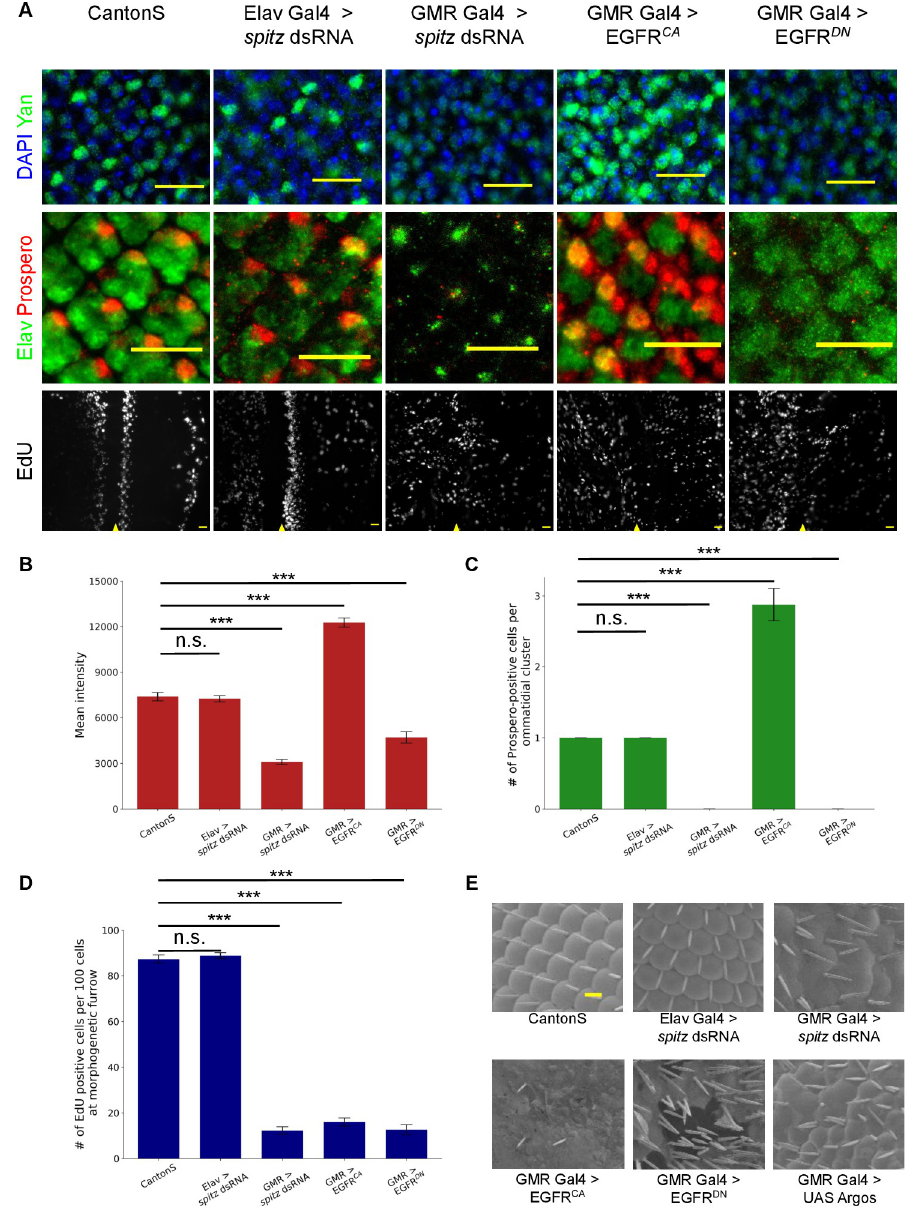
Fig 5. Abnormal EGF receptor activity disrupts cell differentiation and cell division in the developing eye discs. Markers for proximate EGFR signaling (Yan), neuronal differentiation (Elav and Prospero) and cell division (EdU) are stained in eye discs from CantonS and discs with altered EGFR activity. (A) Yan intensity (first row) is similar in CantonS and Elav-Gal4 driving spitz dsRNA discs, whereas Yan intensity decreases when GMR-Gal4 drives spitz dsRNA or EGFR DN and increases with EGFR CA . In CantonS eye discs, Elav stains all eight neuronal cells whereas Prospero stains only R7. The differentiation pattern is maintained in discs from Elav-Gal4 driving spitz dsRNA. Prospero-positive cells per cluster increased in discs when EGFR CA is driven by GMR-Gal4 whereas the signal was completely abrogated in discs when spitz dsRNA or EGFR DN was expressed. Eye discs were stained with EdU to visualize the band of S-phase cells posterior to the MF. Discs from CantonS and Elav-Gal4 driving spitz dsRNA showed the S-phase band which was absent when GMR-Gal4 was driving spitz dsRNA, EGFR CA and EGFR DN . The intensity of Yan (B), number of Prospero-positive cells per ommatidial cluster (C) and number of EdU positive cells per 100 nuclei near morphogenetic furrow (D) are quantified. In all the quantifications, there is no significant difference between CantonS and progeny of Elav-Gal4 driving spitz dsRNA (p-values > 0.05 (n.s.) in a Student’s t-test) and the difference with all crosses with GMR-Gal4 was significant (p-values < 0.001 ( ��� ) in a Student’s t-test). Error bars in (B), (C) and (D) are standard errors of mean. (E) Zoomed-in SEM images showing ommatidial clusters and